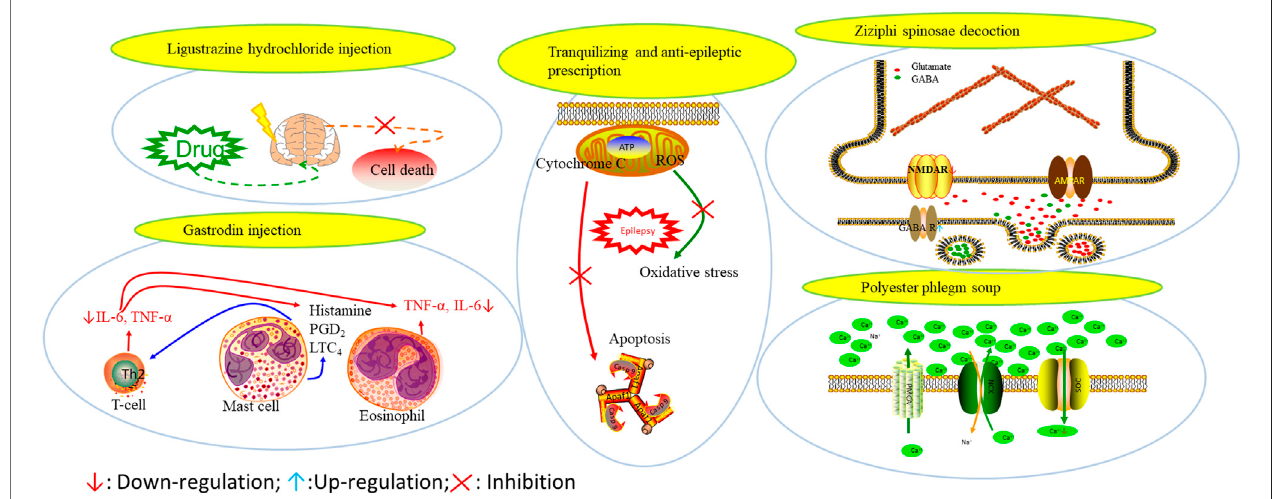
FIGURE 4 | The therapeutic mechanism of integrated Chinese and Western medicine. Interleukin 6 (IL-6), reactive oxygen species (ROS), tumor necrosis factor- α (TNF- α ), prostaglandin D2 (PGD2), leukotriene C4 (LTC4), γ -aminobutyric acid (GABA).